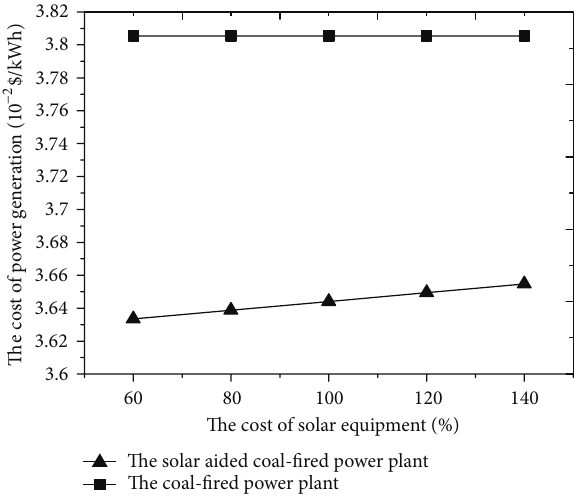
Figure7:Thechangeofthecostofelectricitywiththesolarfacilities’ investment.